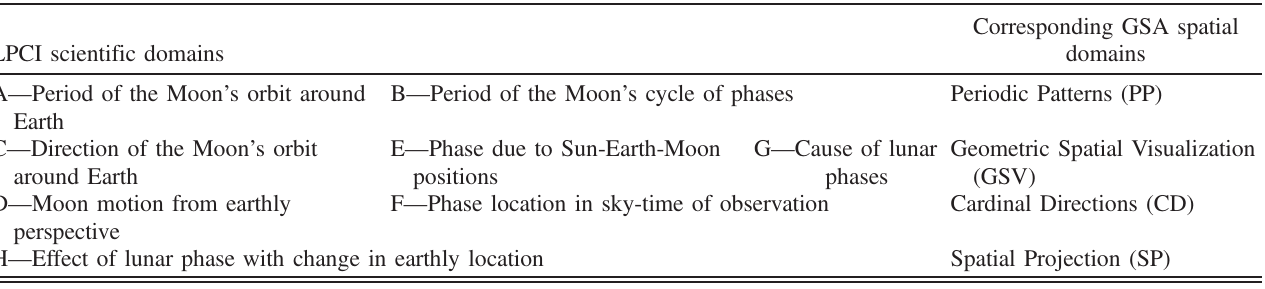
TABLE V. Concept domains: Lunar Phases Concept Inventory (LPCI) science domains and corresponding Geometric Spatial Assessment (GSA) domains